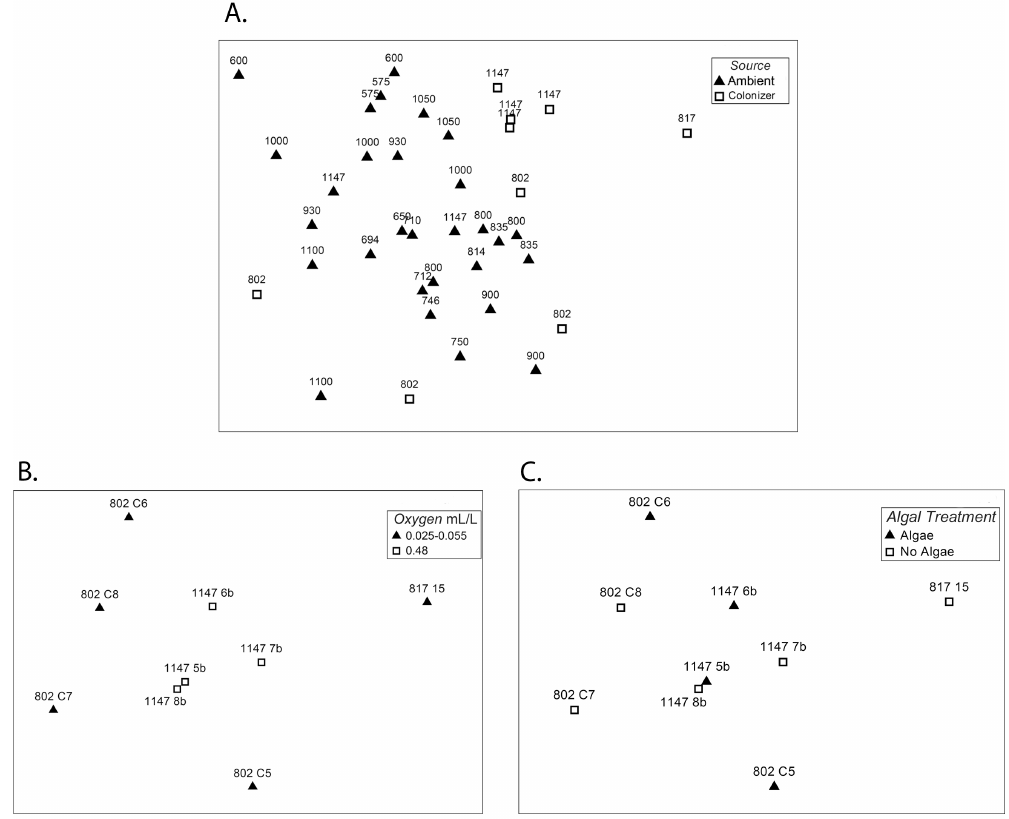
Fig. 7. Multidimensional scaling plot for metazoan macrofaunal community composition comparing (A) ambient fauna (closed symbols) and colonizers (open symbols), ANOSIM: R = 0.263, p = 0.002; (B) tray colonizers in high oxygen (open square) and low oxygen (closed triangle) stations, ANOSIM: R = 0.500, p = 0.024; and (C) trays with labeled phytodetritus (closed symbols) and without phytodetritus (open symbols), ANOSIM: R =− 0.084, p = 0.81